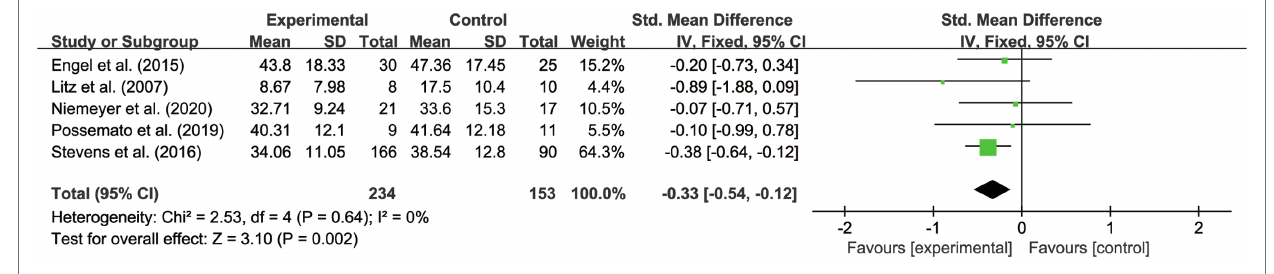
FIGURE 8 | Forest plot of results without the study with female samples only.